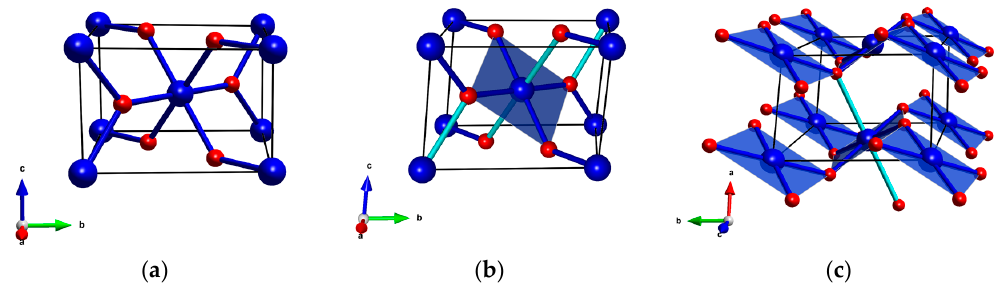
Figure 1. ( a ) The rutile aristotype ( P4 2 / mnm ); ( b ) The CuF 2 structure in the P2 1 / n setting; and ( c ) the same structure in the P2 1 / c setting. Blue/red balls mark metal/ligand atoms (Cu/F in case of CuF 2 ); for CuF 2 dark blue cylinders depict short Cu-F bonds (1.9 Å); light blue cylinders depict long bonds (2.3 Å).